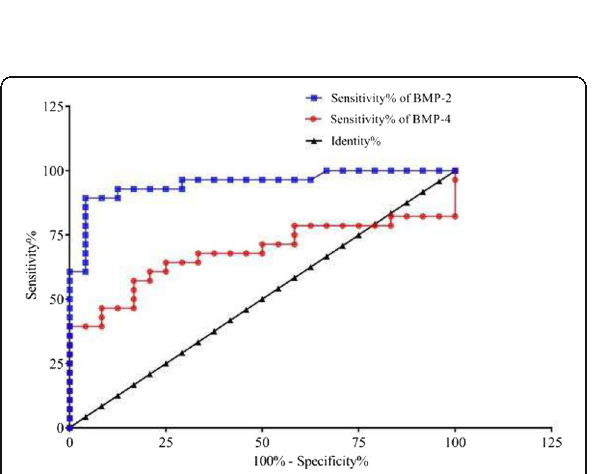
Fig. 2 (abstract 0122). ROC curves for BMP-2 and BMP-4 in separating sepsis from healthy volunteers